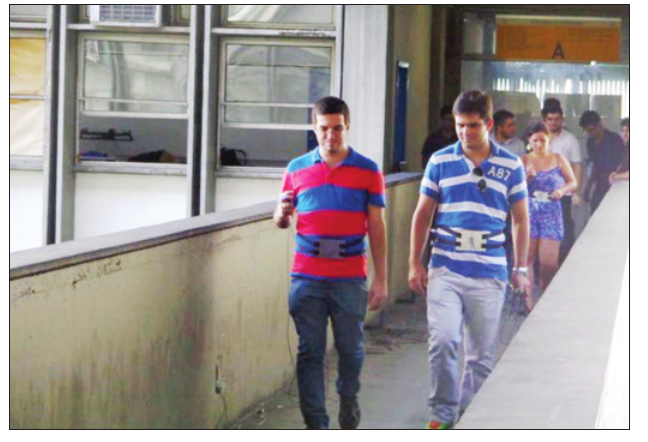
(a) Photo of the walking along the Figure 13 Walking of 12 people on the footbridge